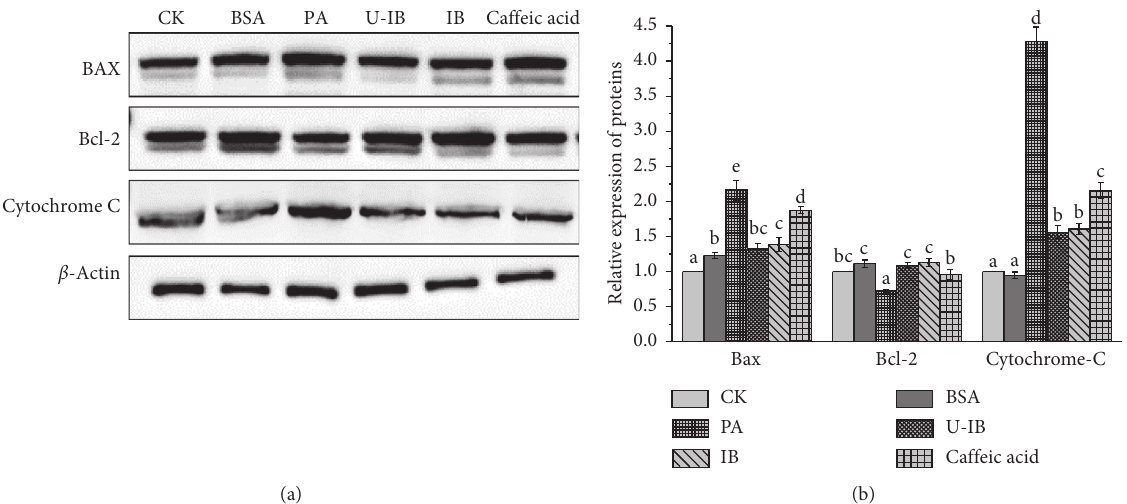
Figure 6: (a) Effects of insoluble-bound fraction and caffeic acid on the protein expression levels of Bax, Bcl-2, and cytochrome C, (b) the relative protein expression levels. Protein expression levels were normalized with β -actin according to grayscale. Data are expressed as mean ± SD ( n � 3). In Figure 6(b), mean values with different letters are significantly different ( p < 0 . 05). CK: control group; BSA: BSA/ NaOH complex solution; PA: PA/BSA complex solution; Bax: Bcl-2-associated X protein; Bcl-2: B cell lymphoma-2; IB: insoluble-bound phenolic fraction; U-IB: UHP-treated insoluble-bound phenolic